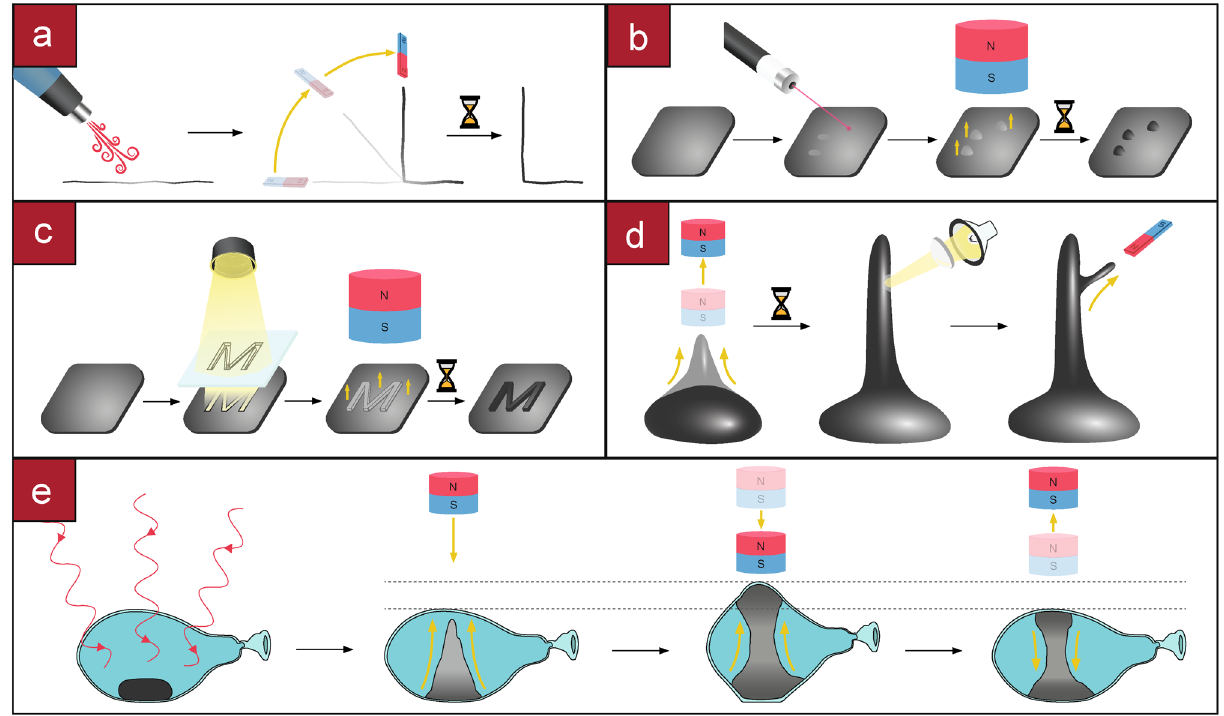
Figure 1. Manipulations on a ferromagnetic thermoplastic using thermal patterns and magnetic fields. (a) Hot air makes the centre of a filament malleable, a magnetic field pulls one side of the filament that bends along the heated area, on cool down the filament is solidified. (b) A laser heats up specific points on a sheet, a magnetic field attracts those points upwards, on cool down the raised points are fixed and can be pressed without deformation. (c) A 2D pattern is illuminated into a sheet of material, when a magnetic field is applied, the heated areas rise and on solidification they become embossed. (d) A blob of material rises into a column, a point on the column is heated and a secondary branch is pulled from it. (e) Microwaves can heat the material when it is inside an optically opaque material for example to expand its container or actuate